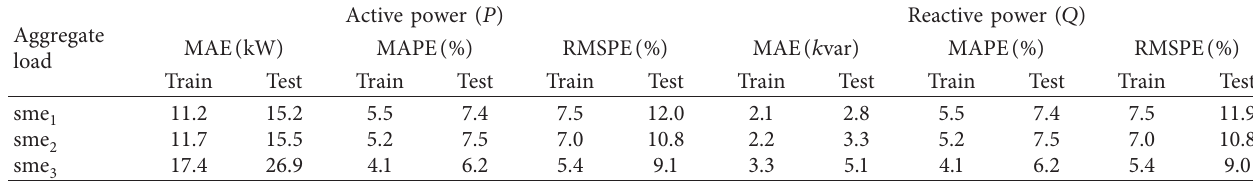
Table 2: Performance of the neural load forecasting models for the SME aggregated loads (training and test). Aggregate load